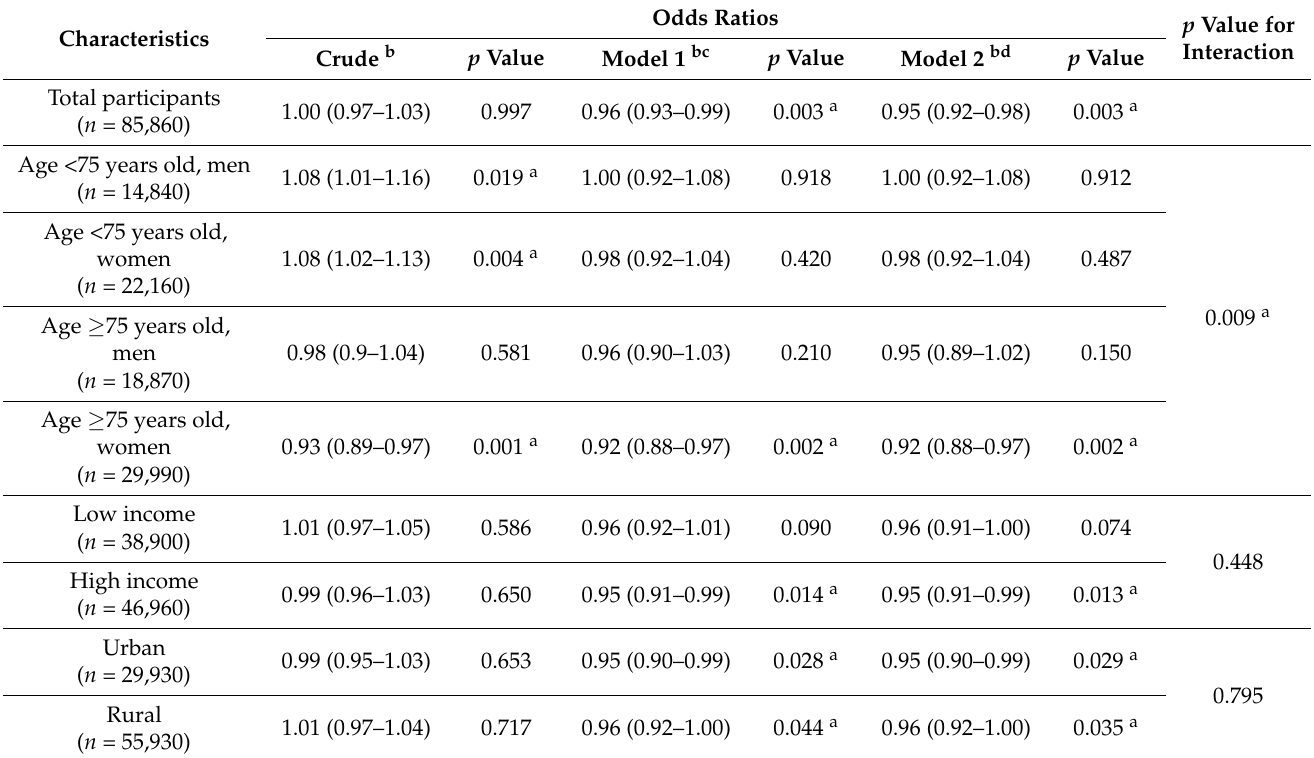
Table 2. Odds ratios (95% confidence interval) for the days of statin use per year in Alzheimer’s disease patients compared to control participants, with subgroup analyses according to age, gender, income, and region of